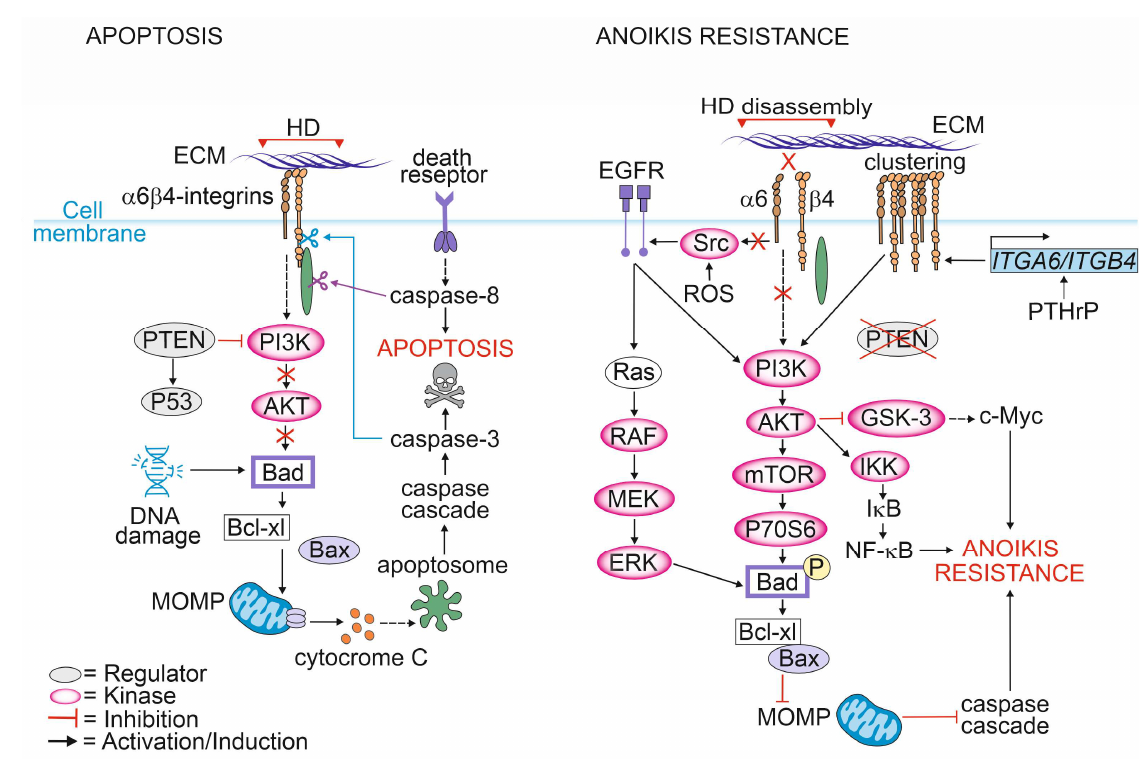
Figure 2. Mechanisms of apoptosis resistance induced by hemidesmosomal proteins.